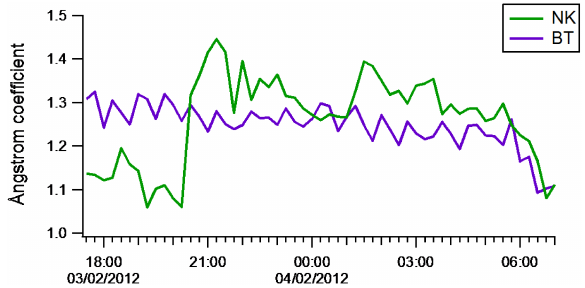
Figure 14. Time series of the calculated absorption Ångstrom coef- ficient during the de-coupling event from Fig.